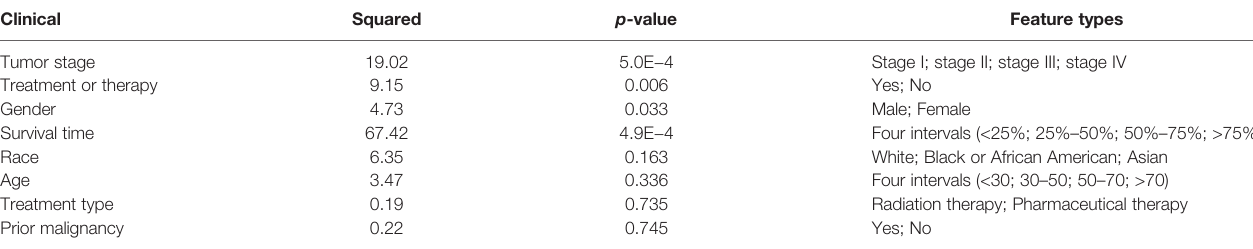
TABLE 3 | Correlations between the predicted risk subgroups and clinical covariates. Clinical